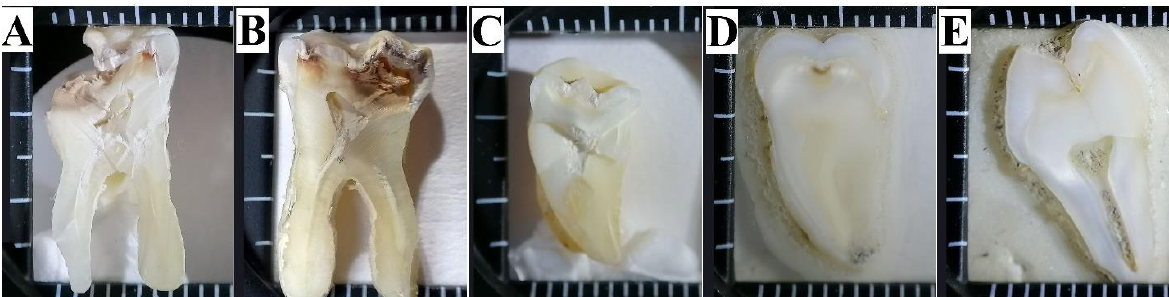
Figure 1. Optical images of the human teeth samples studied in this work. ( A – E )-Sample Group name (see Table 1).